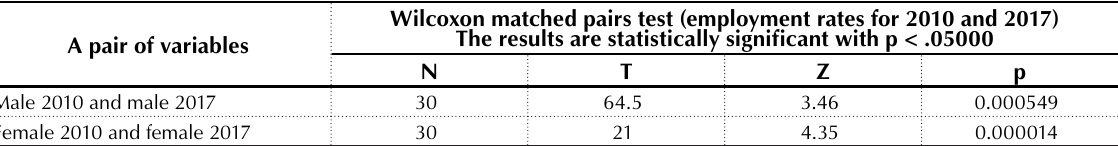
Source: Author’s